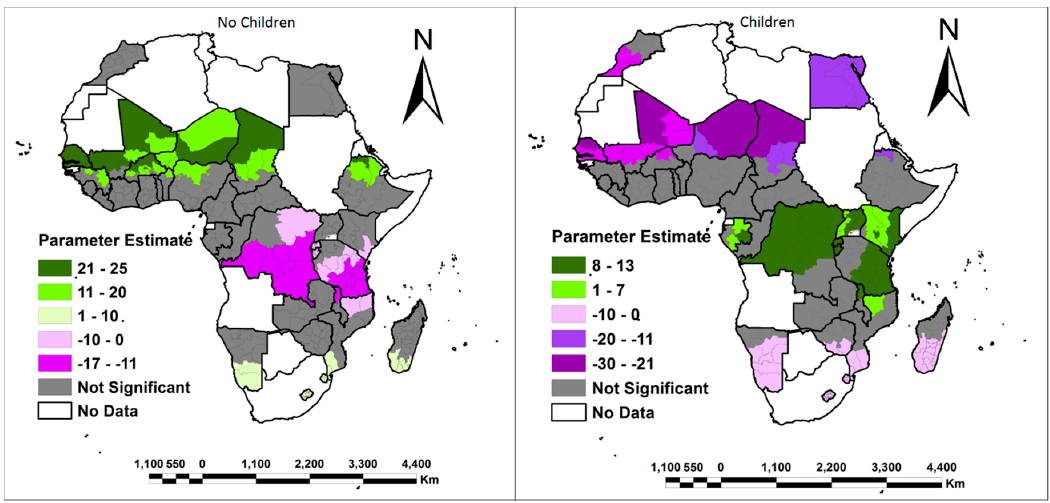
Figure 10. Spatial distribution and significance of children on women’s access to family land.